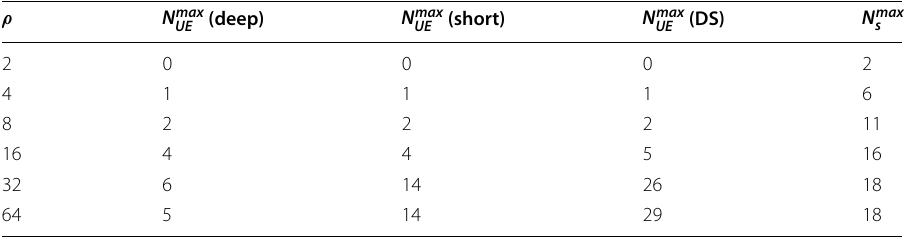
Table 7 Maximum number for N UE in channel scenario